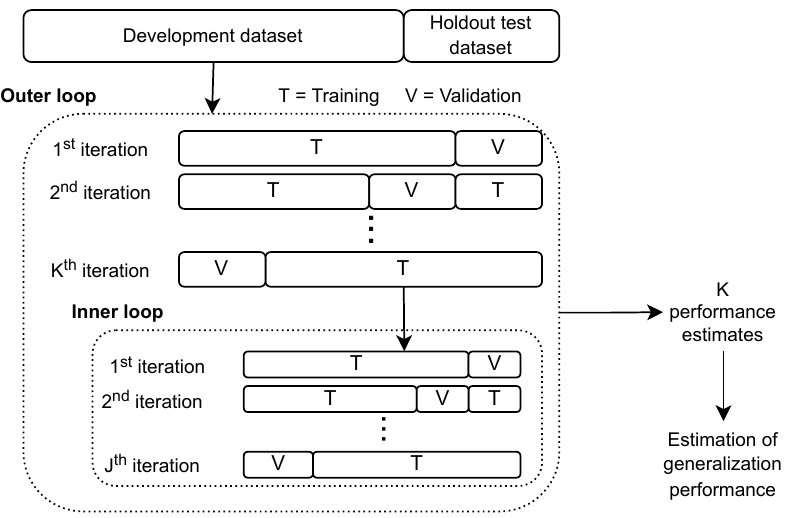
Figure 11. The nested CV procedure, which is used to estimate the generalization performance of the BRB detection